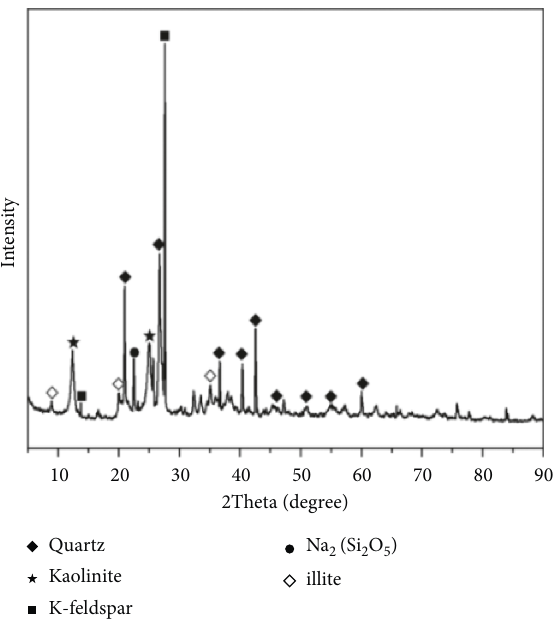
Figure 14: XRD patterns of